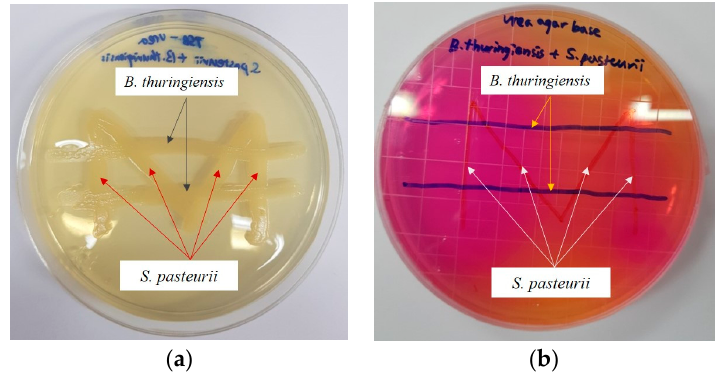
Figure 1. Optical density measurement for cell growth in urea–TSB medium over time.